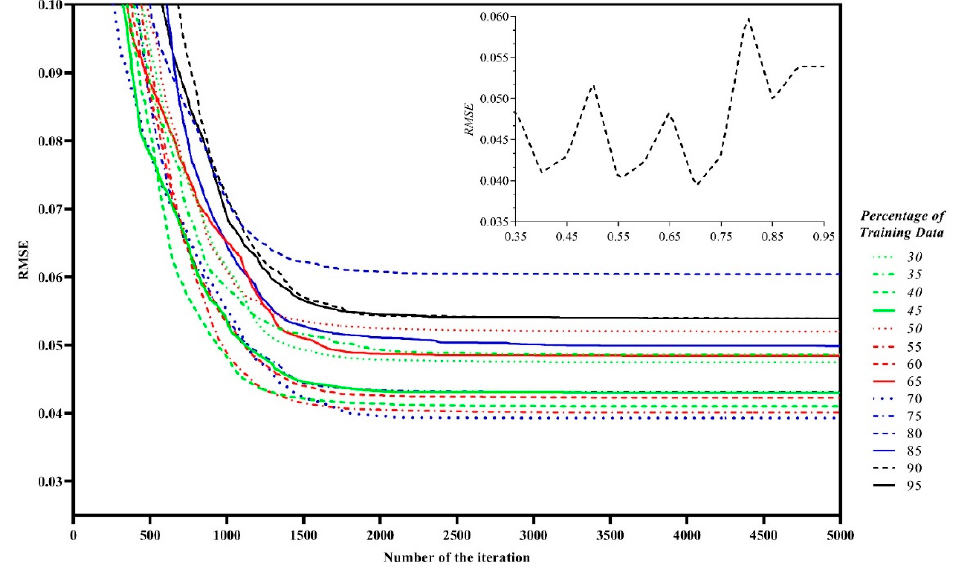
Figure 14. ANFIS-PSO: evolution of the RMSE during the optimization by PSO, as a function of data proportioning.